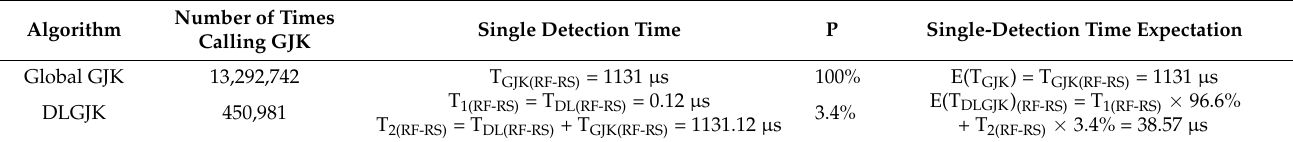
Table 8. RF-RS workspace self-collision detection time expectation of Global GJK and DLGJK.